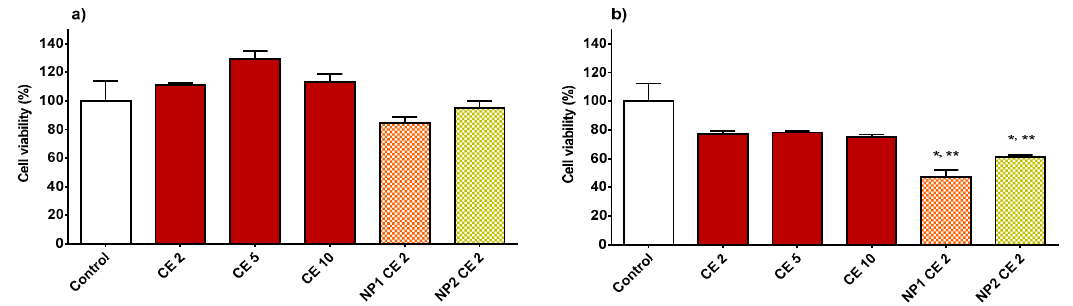
Figure 3. Human umbilical vein endothelial cell (HUVEC) viability after 2 h ( a ) or 24 h ( b ) of incubation with empty NP1 or NP2 (0.0125 to 0.5 mg/mL) in culture medium. Data are expressed as % viable cells compared to 100% of control (untreated cells). *, significantly different from control; **, ***, significantly different from each other.